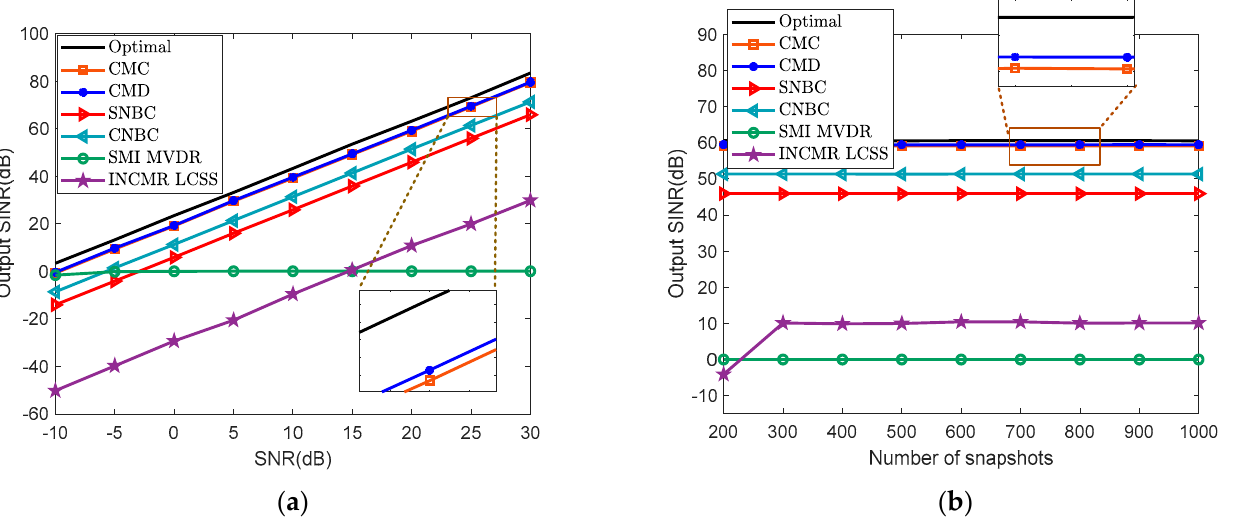
Figure 8. The output SINR of different methods. ( a ) The output SINR versus SNR. ( b ) The output SINR versus the number of snapshots.